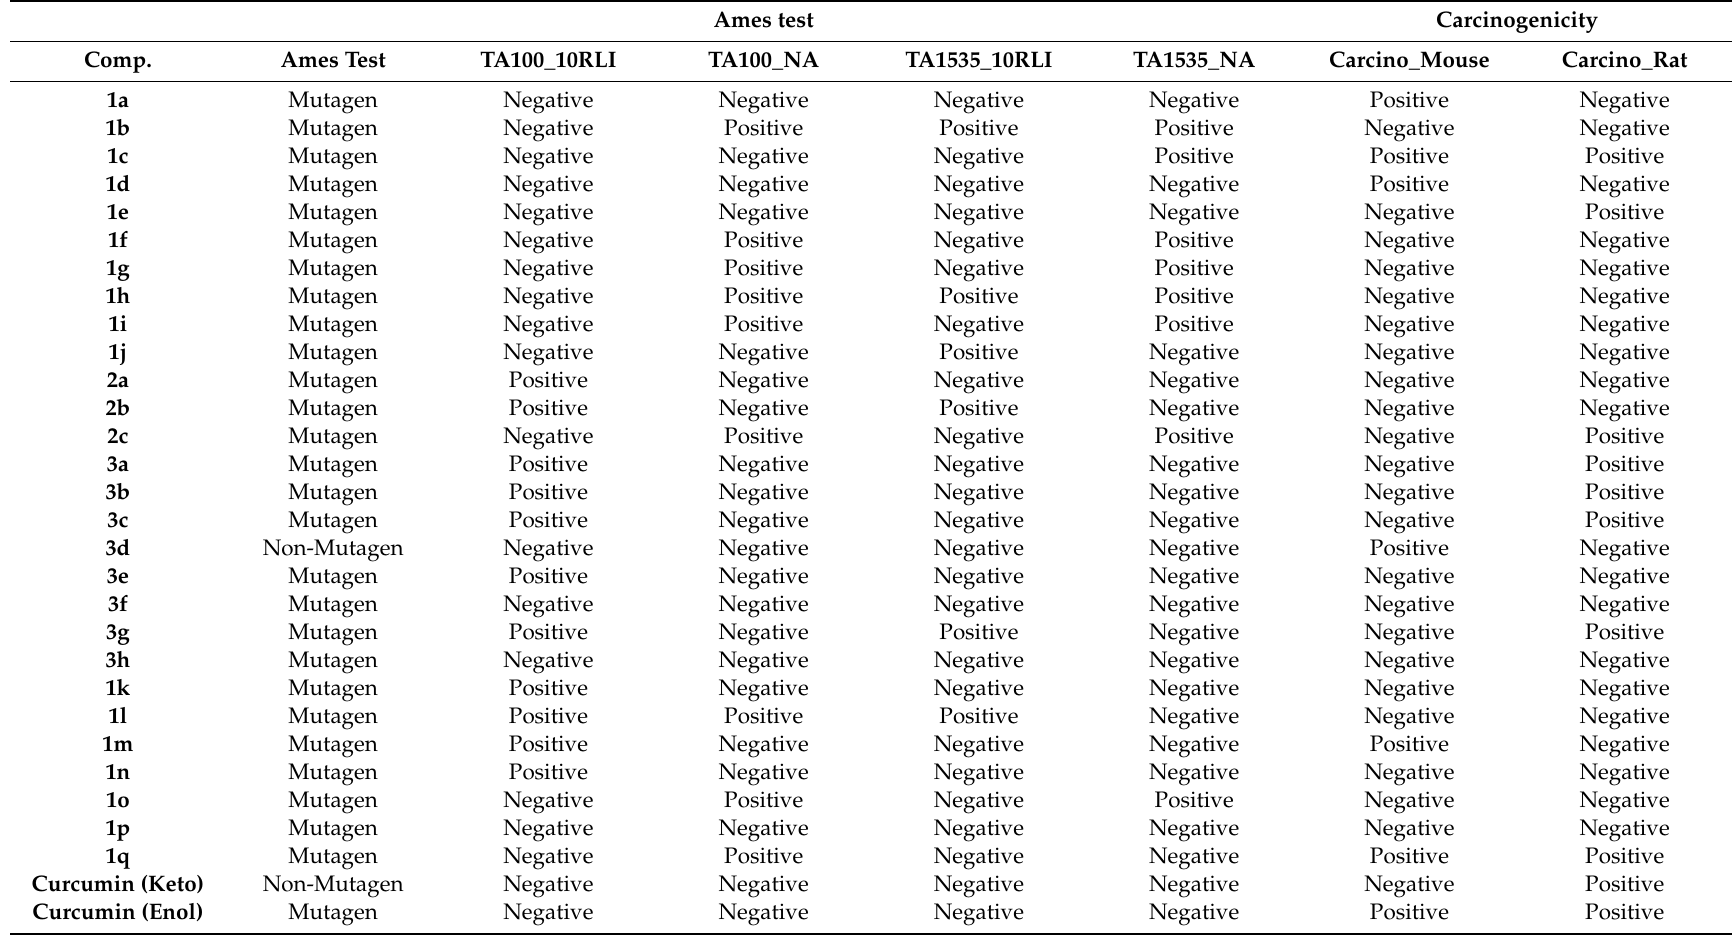
Table 4. Toxicity assessment of the synthesized compounds calculated by the preADMET platform (https: // preadmet.bmdrc.kr / ).